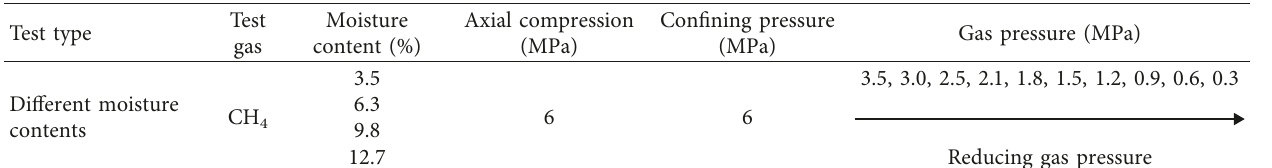
Table 1: Experiments at different moisture